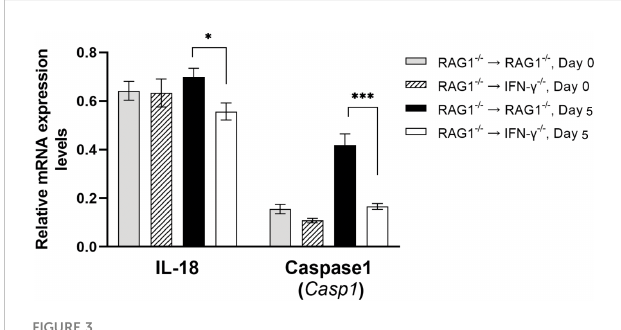
FIGURE 3 Cerebral mRNA levels for molecules that increase phagocytosis of microglia and macrophages are upregulated by IFN- g production by brain-resident cells during reactivation of cerebral T. gondii infection. For the details of experimental methods, see the legend of Figure 1. The mRNA levels for IL-18 and caspase1, which generate active IL-18 molecule from pro-IL-18, were measured at both Day 0 and Day 5 in the brains of both groups of mice were measured using NanoString